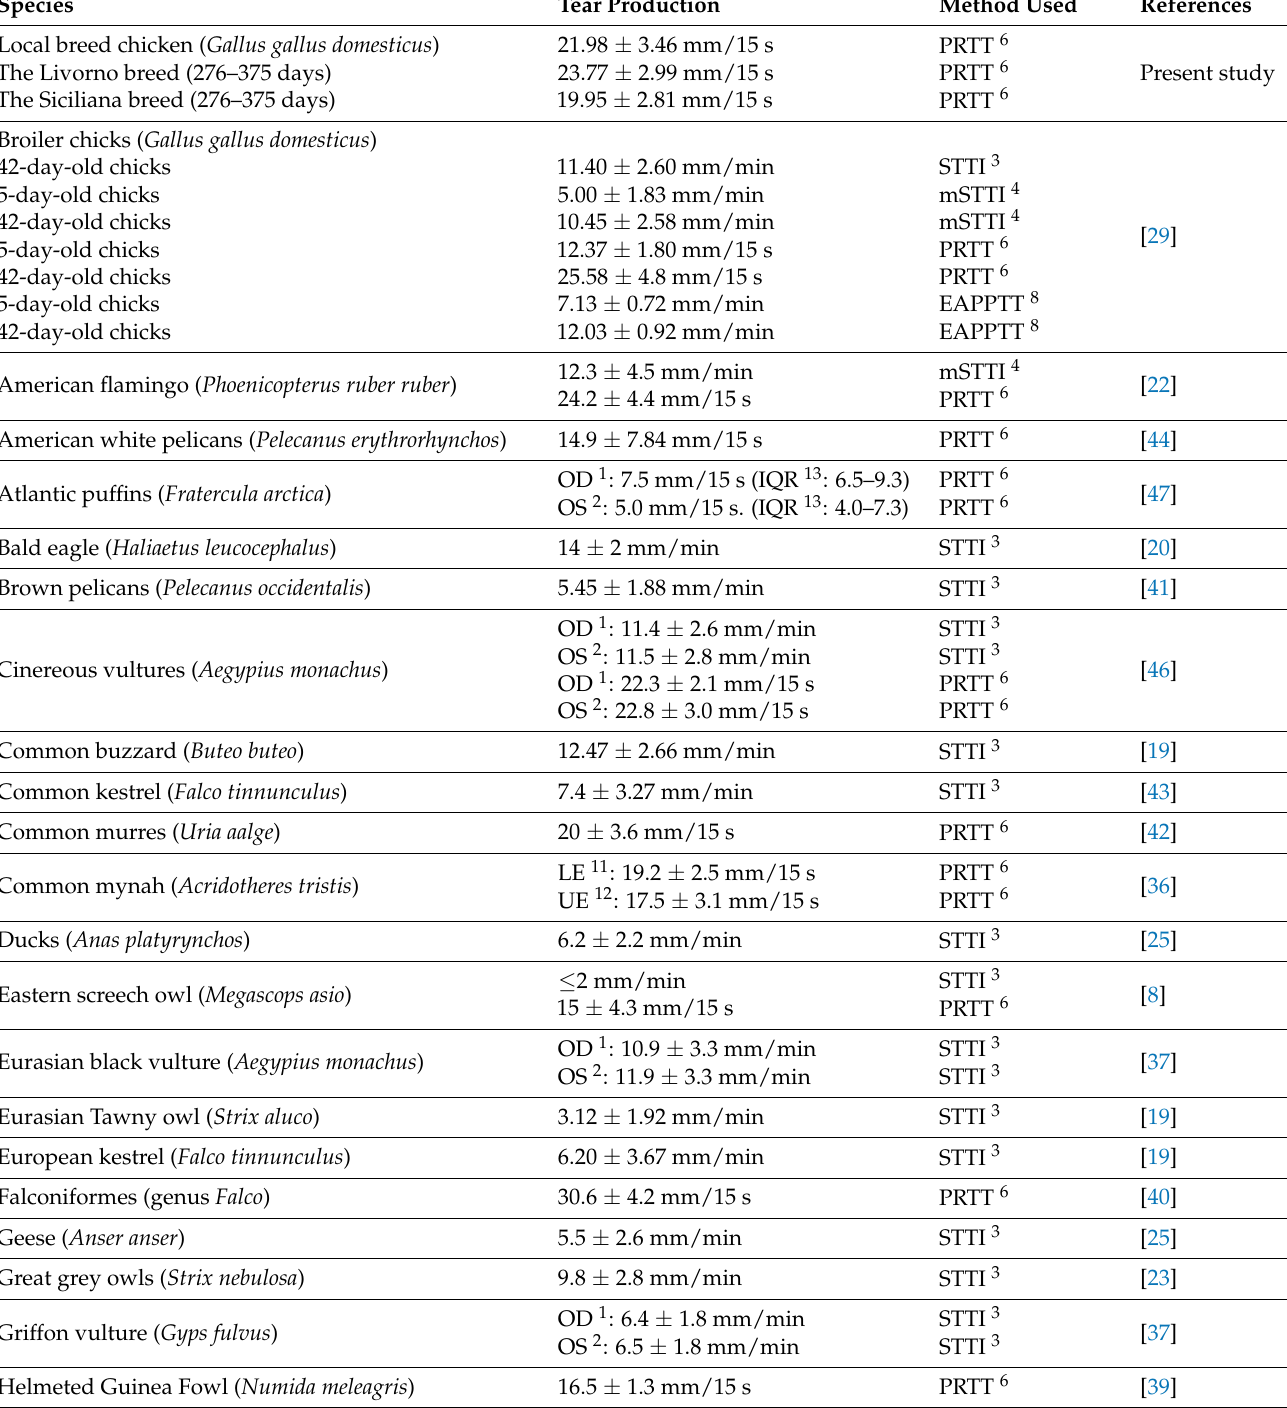
Table 5. The normal values of tear production reported in various avian